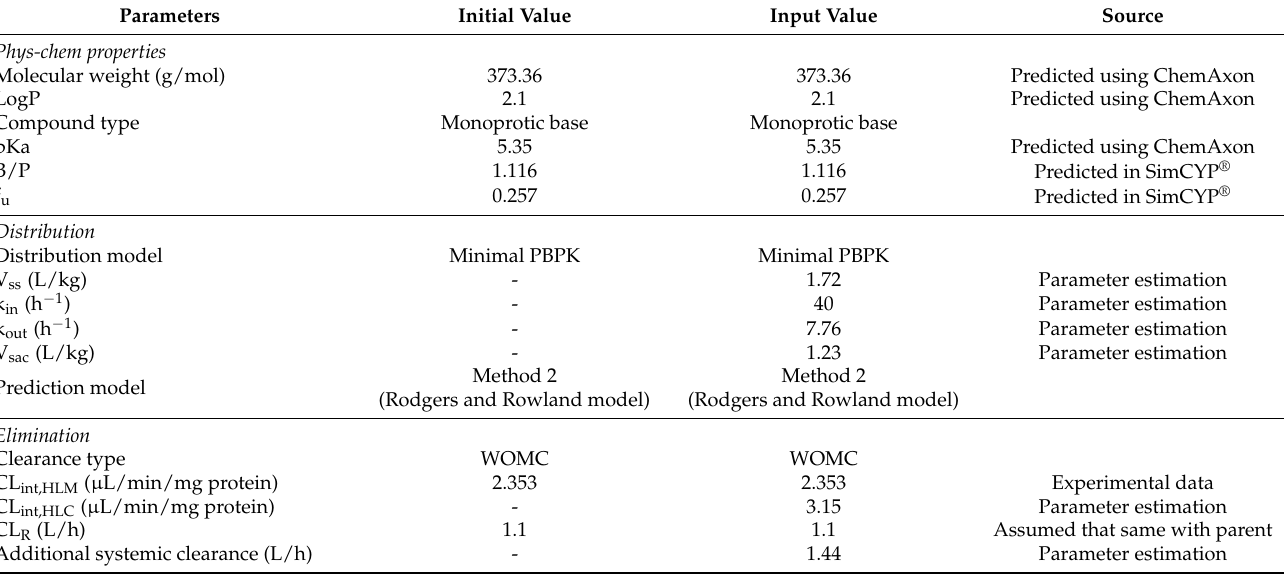
Table 2. The input parameters for the tegoprzan-M1 PBPK